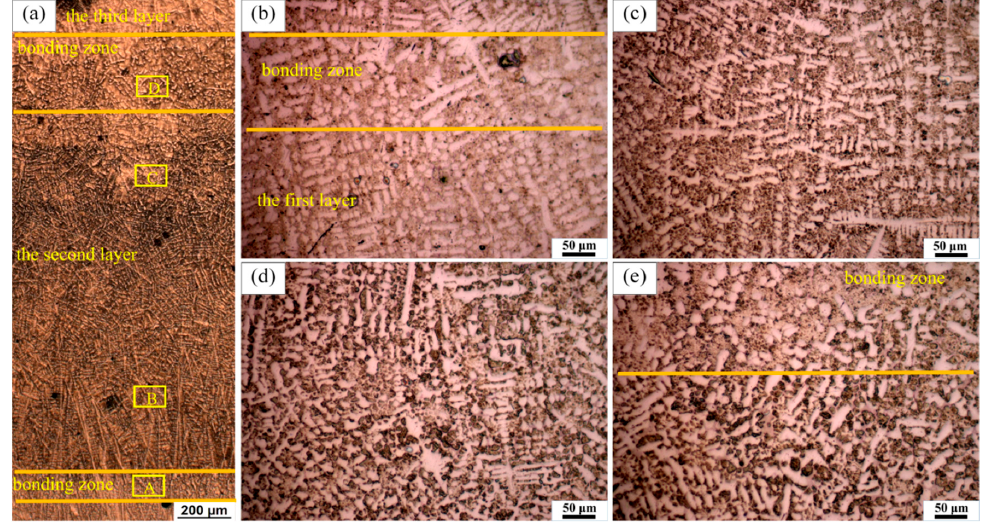
Figure 4. A typical microstructure of the second cladding in sample LC1: ( b – e ) correspond to A–D in ( a ), respectively.